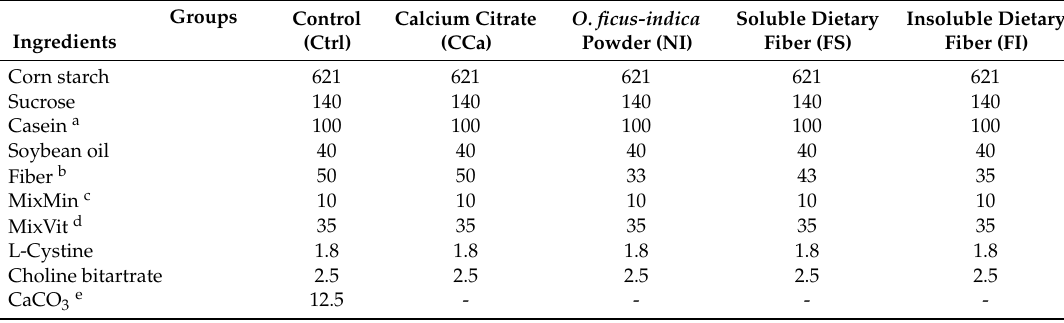
Table 1. Ingredient composition of the experimental diets (g /